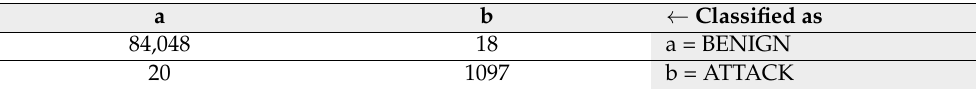
Table 12. Confusion Matrix for J48 on Thursday Morning Web Attacks (binary